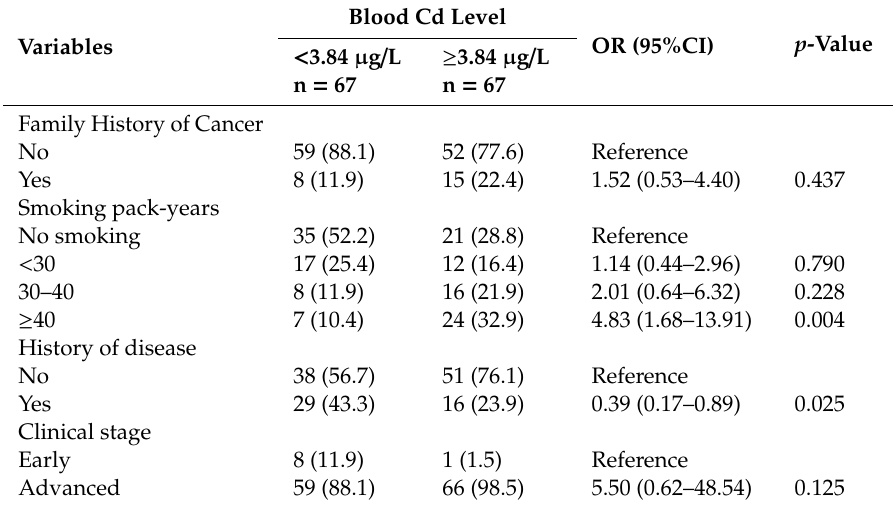
Table 3. Multivariate analysis of factors associated with blood Cd level for NPC patients (n = 134).